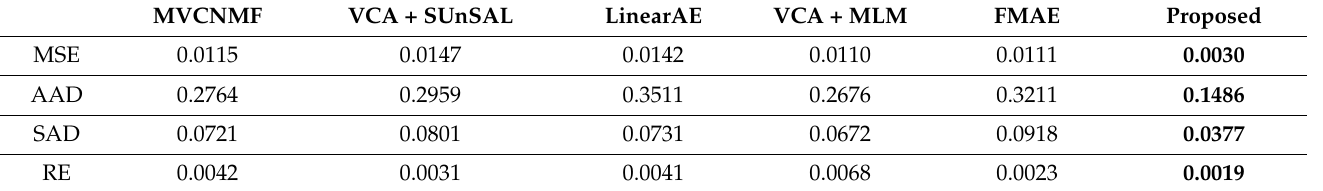
Table 2. Comparison of different methods on Nonlinear Mixed Data. Best results are reported in bold.